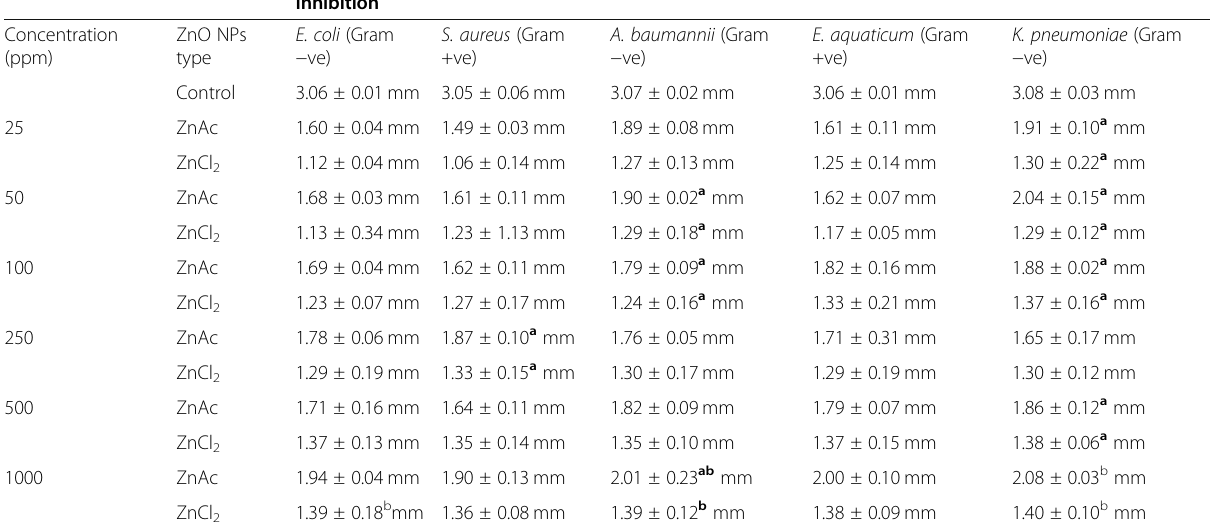
Values are mean ± SD for three determinations a Significantly ( p < 0.05) higher compared at the same concentration in each row b Significantly ( p < 0.05) higher compared at the same concentration in each column